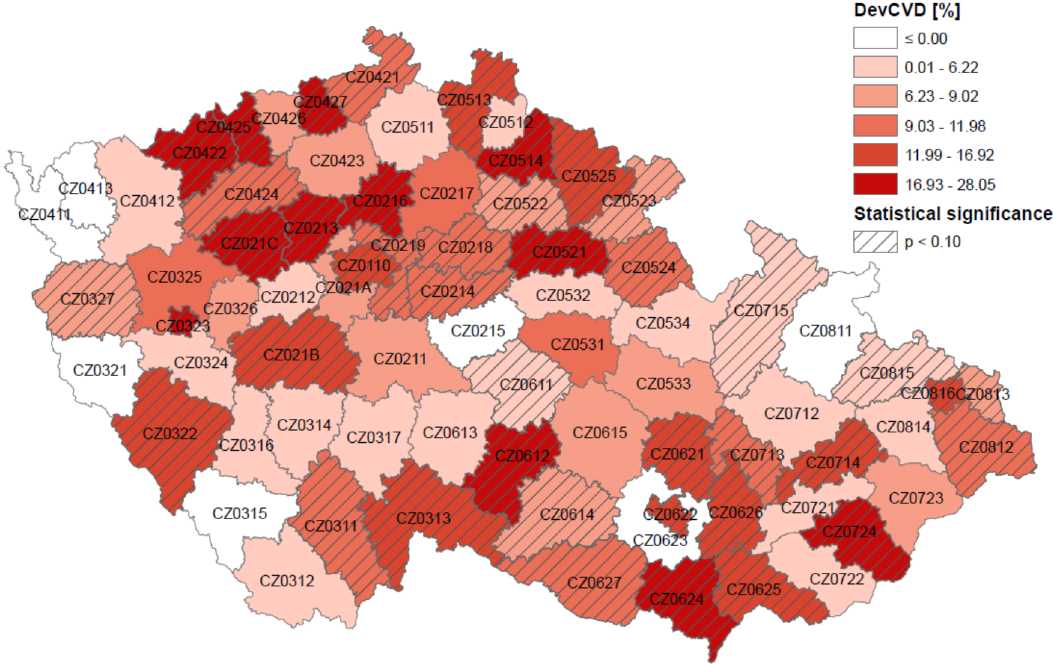
Figure 4. Spatial distribution of mean relative mortality deviations due to CVDs on hot days ( DevCVD ). Districts are labelled according to the Czech Statistical Office coding [48].